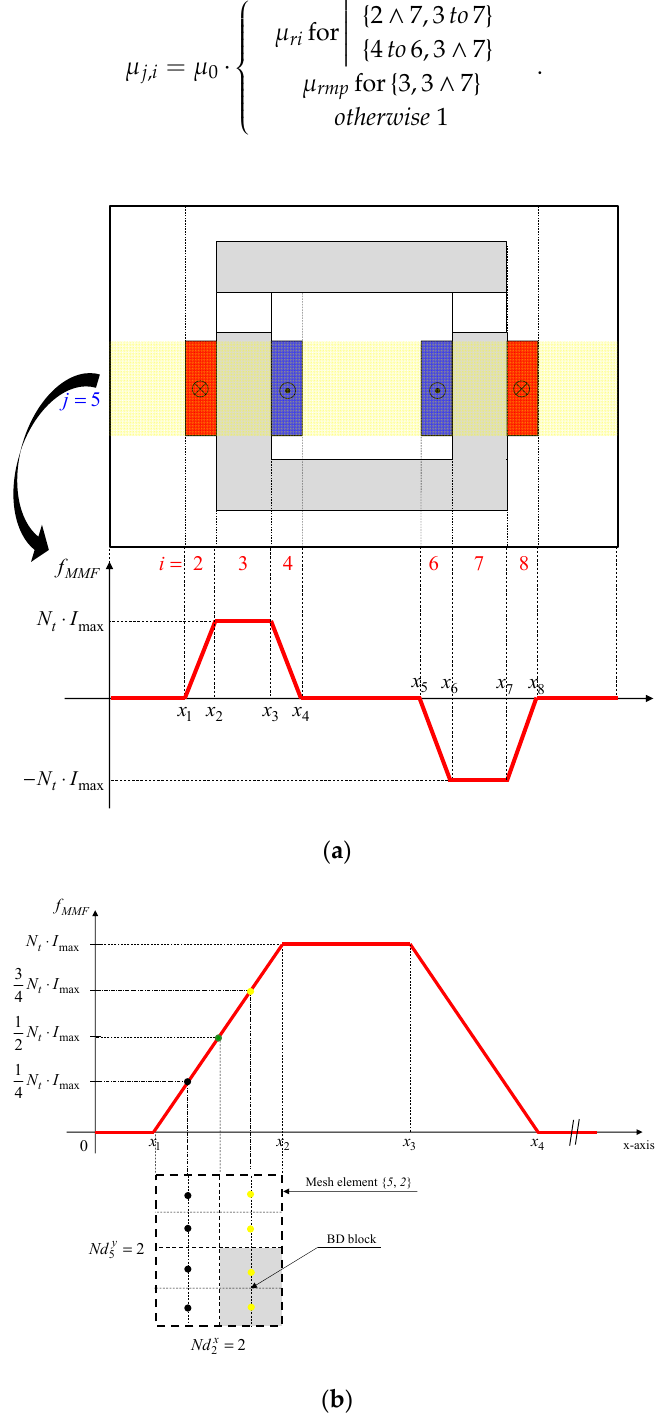
Figure 4. The magnetomotive force (MMF) function f MMF ( N t , I max ) : ( a ) Waveform, and ( b ) MMF values according to the discretization number (e.g., for the mesh element { 5,2 } with Nd y = Nd x 2